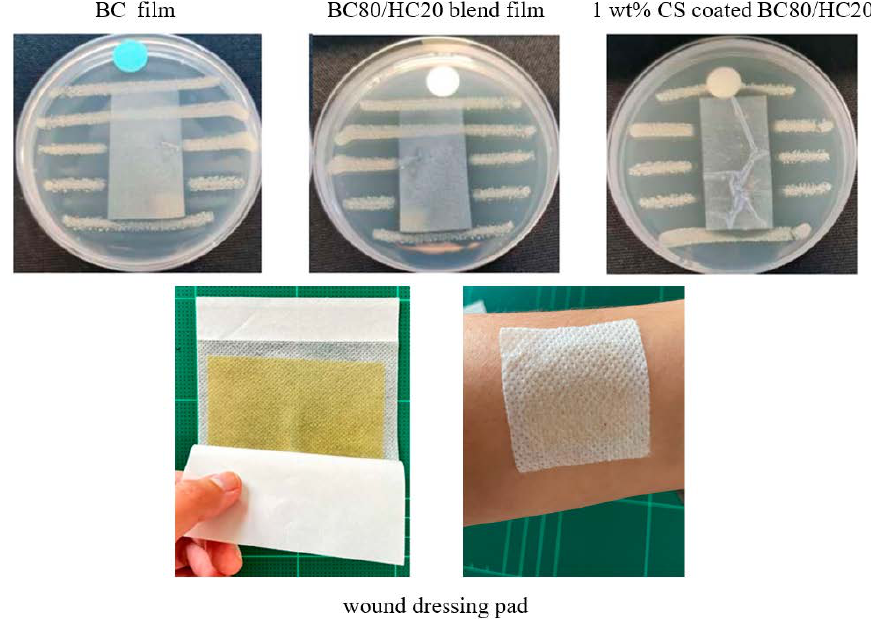
Figure 6. Antimicrobial activity against S. aureus of representative BC film, representative BC:HC film, and representative CS ‐ coated BC:HC film.